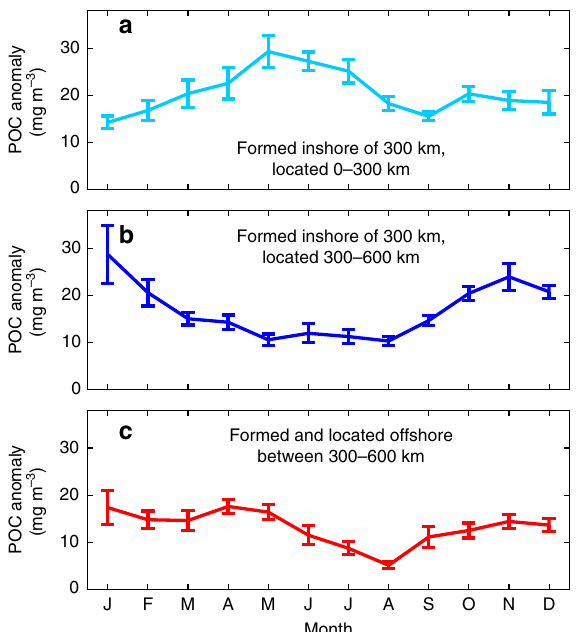
Fig. 6 Estimates of lateral transport by cyclonic eddies in the California Current System. a Average number of cyclones with lifetime longer than 4 weeks in the eddy dataset 1 formed inshore of 300km from the coast that propagate to at least 300km offshore per year grouped by average amplitude of the eddies when they are located offshore of 300km. Total number of cyclonic eddies propagating offshore per year is 6.0±0.6. Error bars represent the standard error. b Mean volume transport (Sv) and standard error in the top 400m by cyclonic eddies calculated assuming that 65±7% of the initially trapped volume of water is transported offshore (see Methods and Supplementary Fig. 3). Total transport summed across the different amplitude bins is 1.06±0.2Sv. c Particulate organic carbon enrichment (Gg year − 1 ) and standard error in the offshore region due to cyclonic eddies generated inshore of 300km from the coast that propagate offshore (see Supplementary Fig. 5). Total particulate organic carbon enrichment summed across the different amplitude bins is 20.9±11 Ggyear −